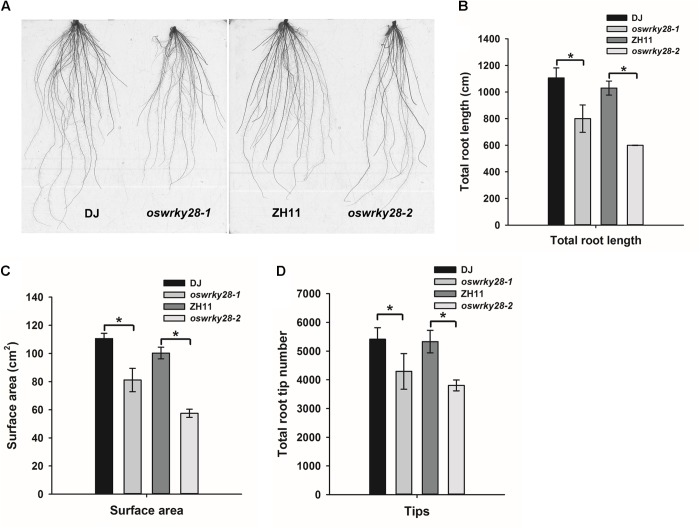
Root architecture of wild-type and oswrky28 plants. Two wild-types and oswrky28 T-DNA mutants were grown under 100 μM Pi conditions for 3 weeks. (A) Root architectural details. (B) Total root length. (C) Root surface area. (D) Total root tip number. Asterisks indicate statistically different at P < 0.05 (Tukey’s test). Values are means ± SE (n = 4 per genotype).